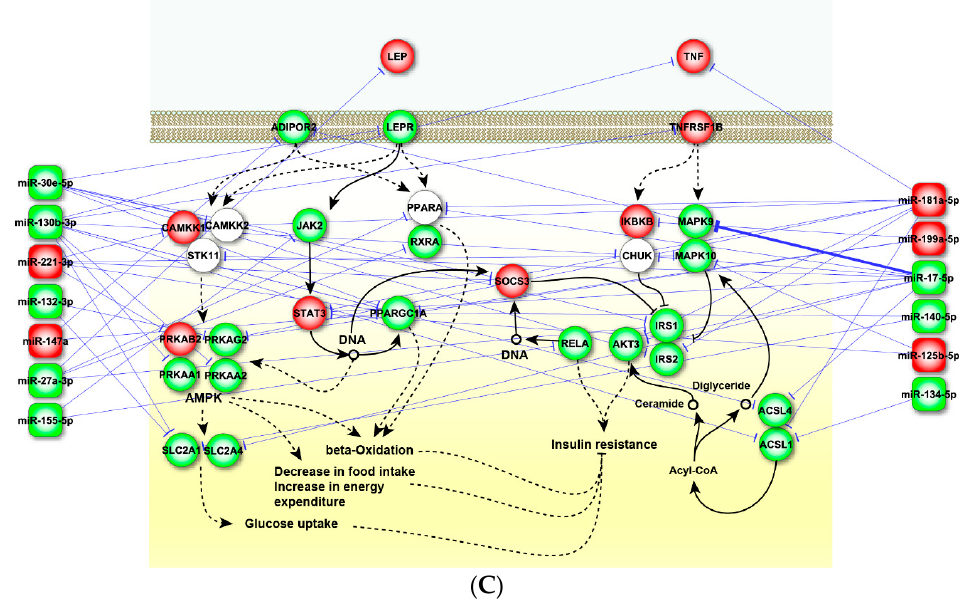
Figure 3. Schematic diagram of the microRNA-mRNA interaction networks in adipose tissue. The networks are built based on the KEGG pathway map: T2DM pathway (KEGG hsa04930) ( A ); adipocytokine pathway (KEGG hsa04920) ( B ); and insulin signaling pathway (KEGG hsa04910) ( C ). The genes are indicated by circles and miRNAs by squares. See the legend of Figure 2A for descriptions of node shape, edge size, edge color and arrow shapes. The identity of genes and miRNAs involved in the process are listed, and the colors indicate the relative expression changes in T2DM adipose tissues compared to the control; red indicates higher level in patients; and green represents lower levels compared to the control. The mRNA expression levels were obtained from GSE16415 (available online: https://www.ncbi.nlm.nih.gov/geo/query/acc.cgi?acc=GSE16415).